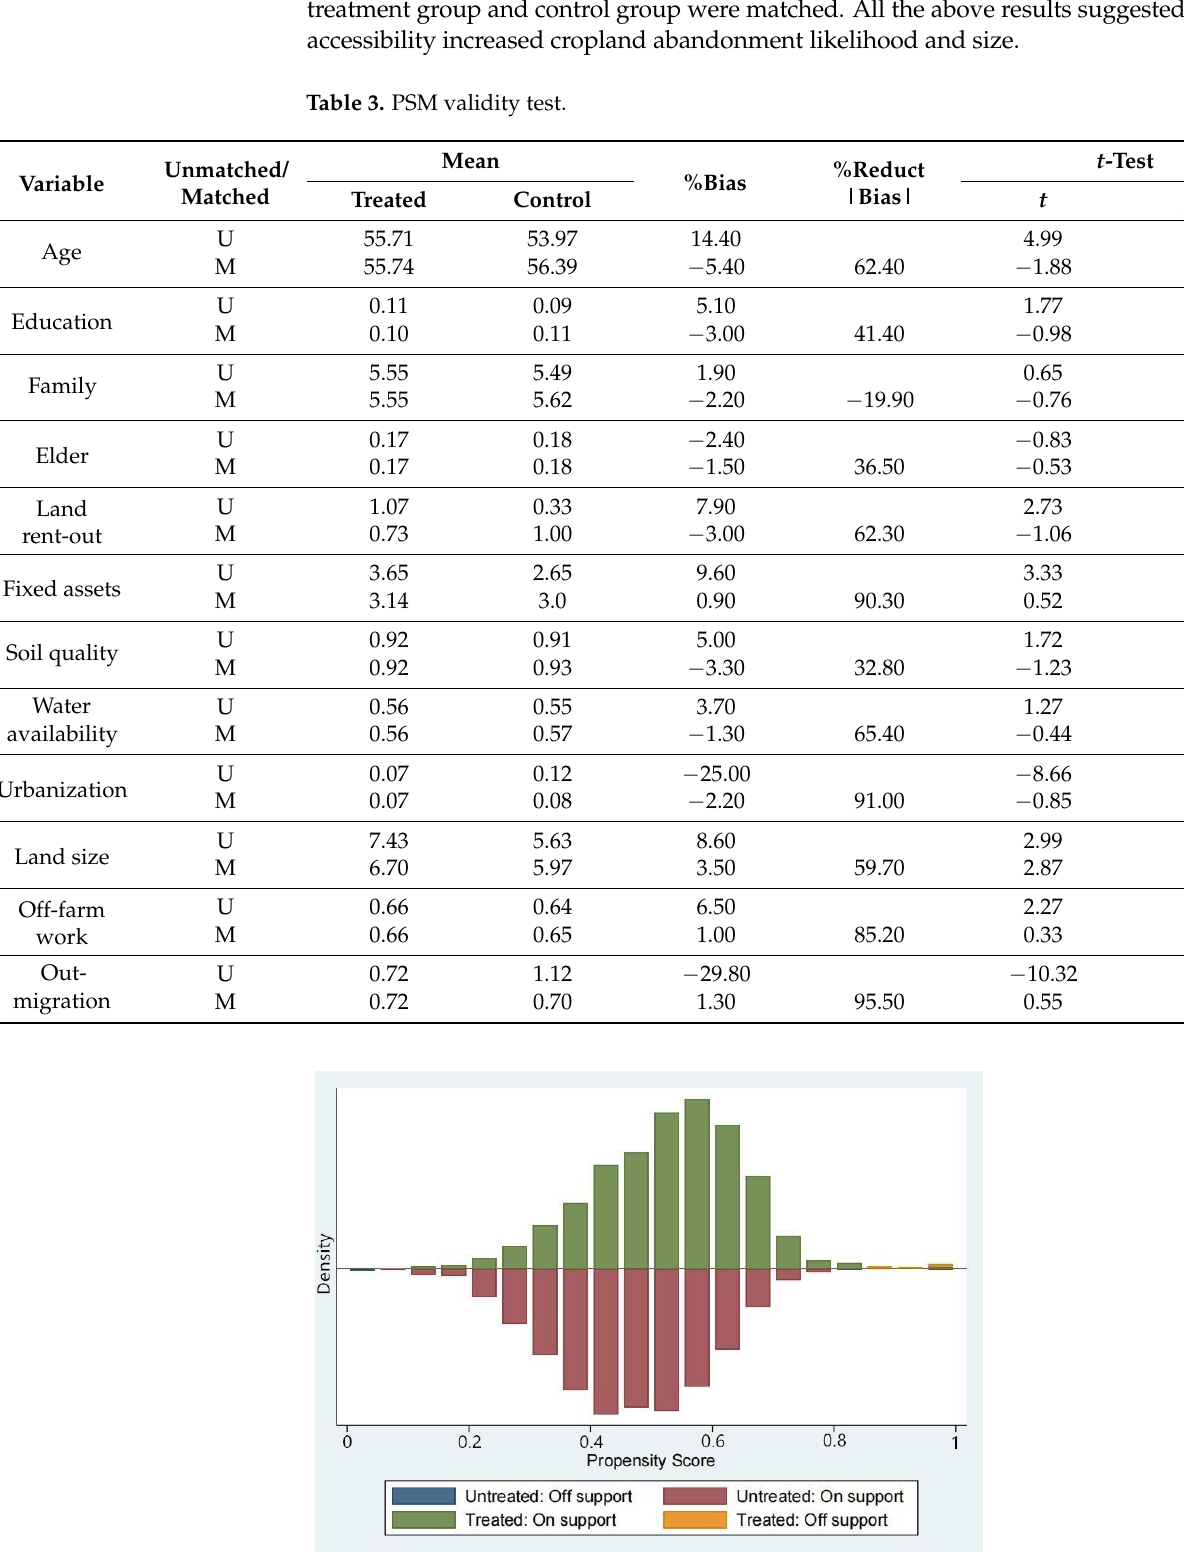
Figure 3. PSM validity test.